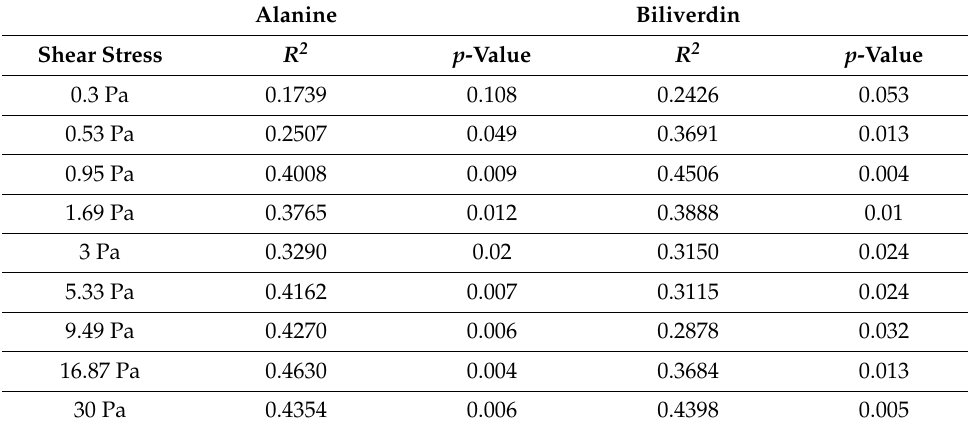
Table 3. Metabolite correlates with deformability. Alanine Biliverdin Shear